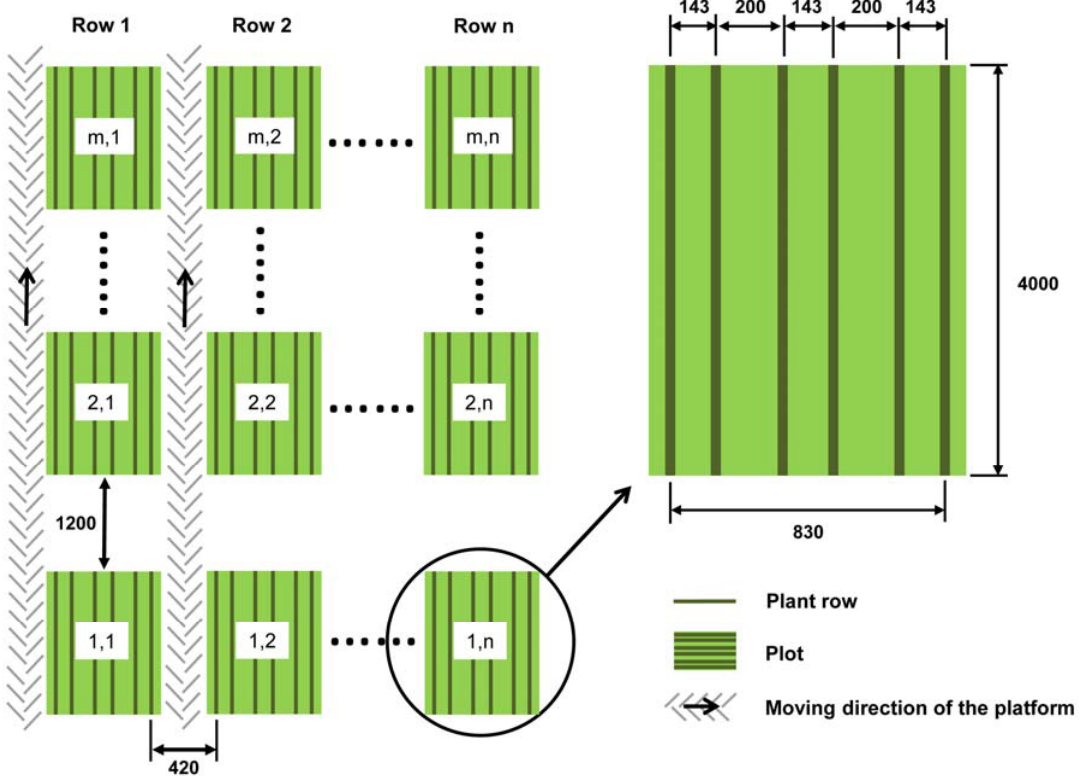
Figure 6. General design of the field trials and moving direction of the platform, the interspaces between the plots and the dimensions of one single yield trial